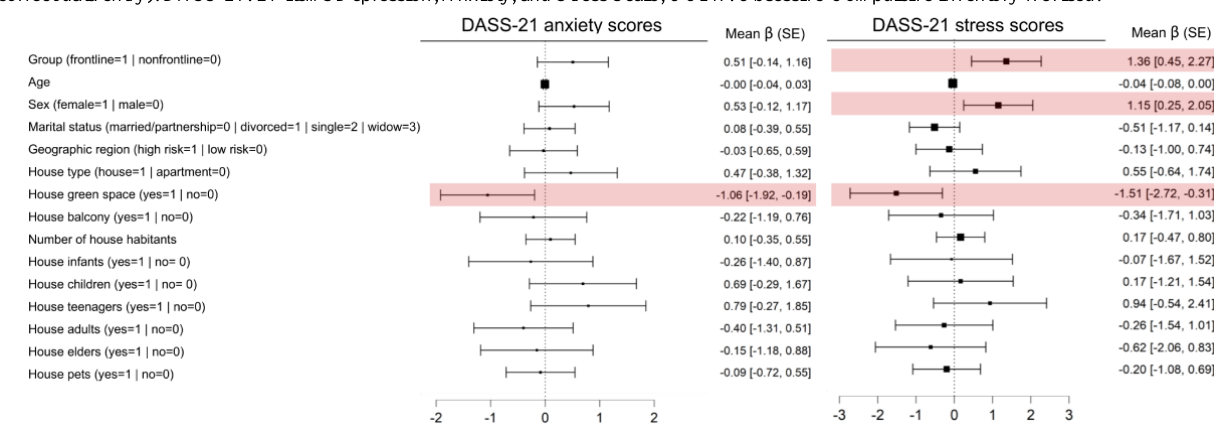
Figure 2. Significant variables in regression models for DASS-21 anxiety and DASS-21 stress scores of Portuguese physicians (n=420) during the COVID-19 pandemic (May 4-25, 2020). DASS-21 depression and OCI-R total models did not reach significance. The forest plot represents the mean unstandardized β (SE) values. The red boxes indicate statistical significance. One participant was excluded because of missing information for age (incorrect data entry). DASS-21: 21-items Depression, Anxiety, and Stress Scale; OCI-R: Obsessive-Compulsive